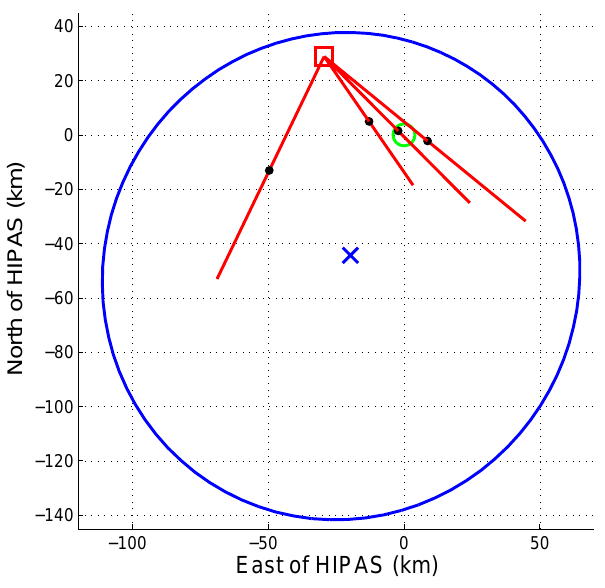
Fig. 2. A sketch showing the observational geometry from above. All positions are relative to the HIPAS site (marked with a green circle), the PFISR radar is located 29.3km east and 28.7km north of HIPAS, the direction of the four radar beams used are marked with red lines. The blue curve marks the 3dB contour of the antenna pattern, the blue cross marks the magnetic field line position both at 210km of altitude, and the black markers on the radar beams are their intersection with the 210km